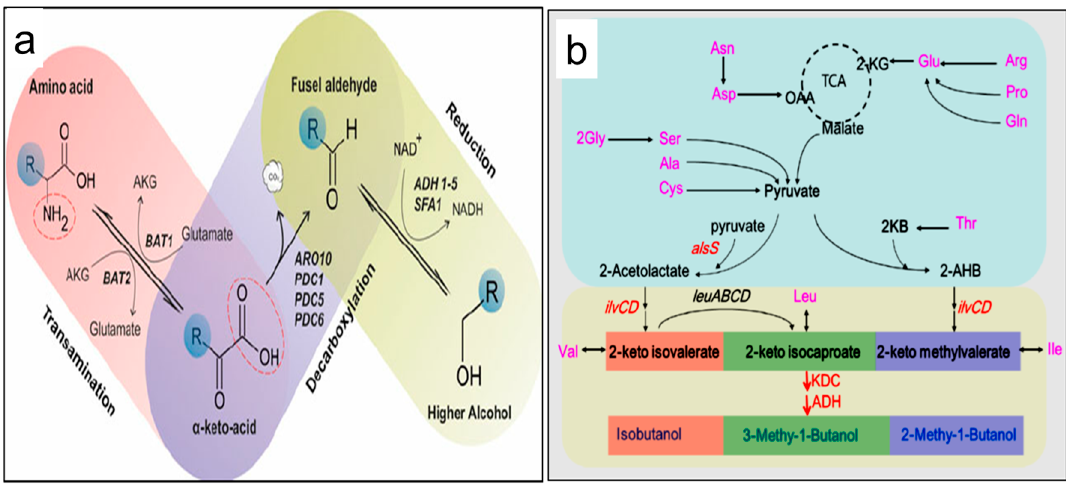
Figure 8. The Ehrlich pathway. Catabolism of branched-chain amino acids (leucine, valine and isoleucine), aromatic amino acids (phenylalanine, tyrosine and tryptophan), and sulfur-containing amino acid (methionine) leads to the formation of fusel acids and fusel alcohols ( a ). The metabolic networks for biofuel production from amino acids ( b ), adapted from [44,85].